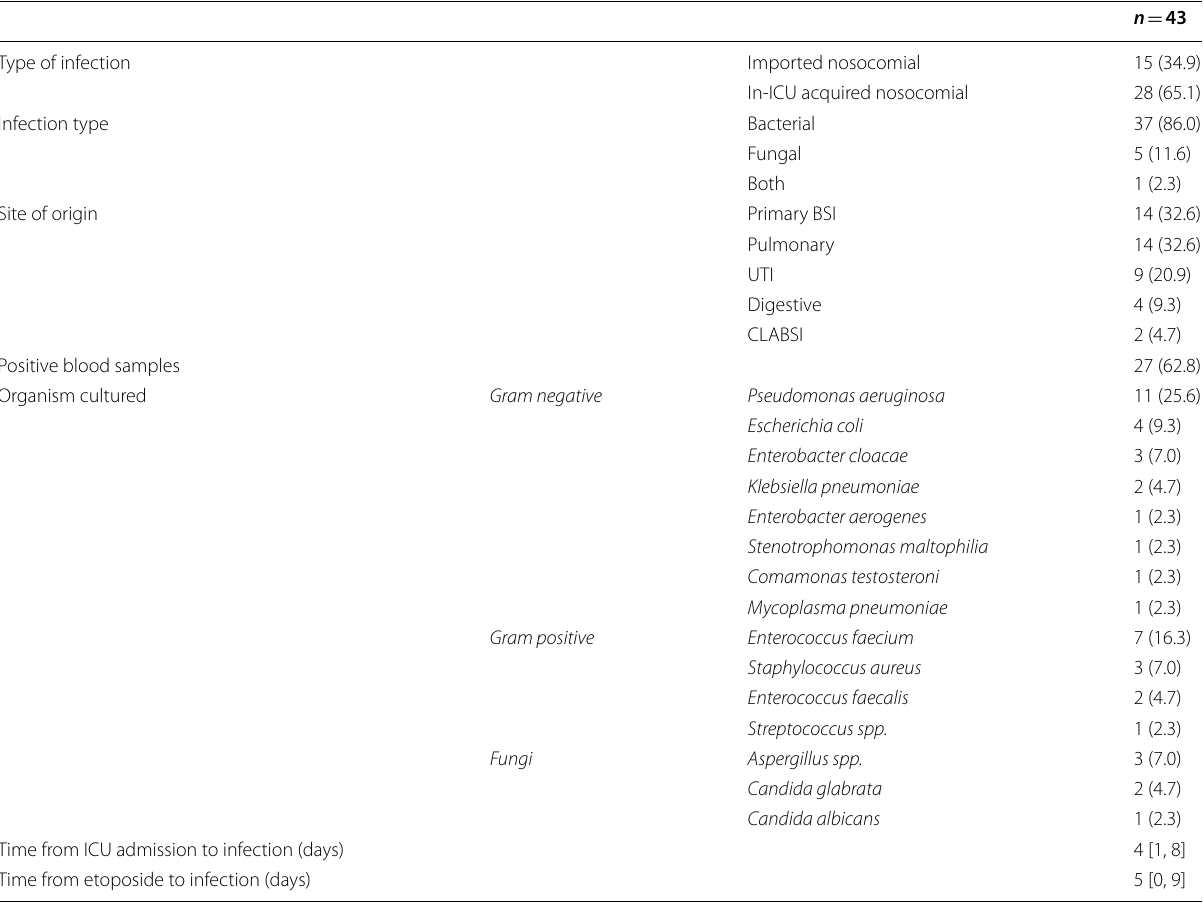
Values are given in N (%) or median